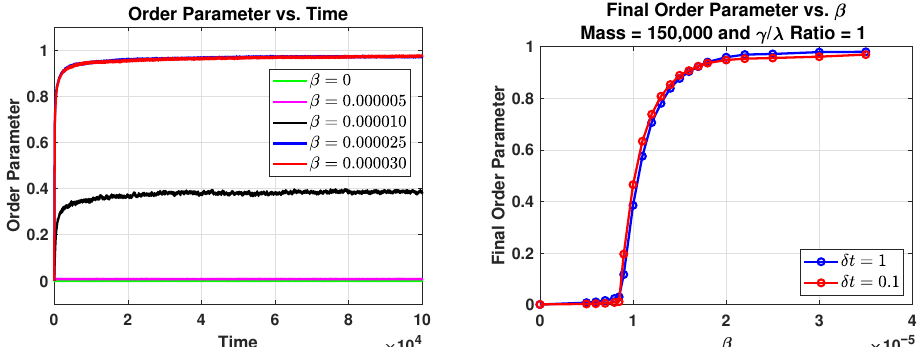
Figure 3. How changing the β parameter affects the system. Here we have N 1 = N 2 = N 3 = 50,000, with λ = γ = 0.5 and the lattice size is 100 × 100. ( Left ) It is seen that for a small β value, the system remains well-mixed and the order parameter is almost zero over all time steps. For larger β values, we see that the order parameter increases quickly as the system segregates and levels off to around one. ( Right ) After 100,000 time steps, we take the order parameter value for different β values. We clearly see that as the β value increases, there is a critical β value at which a phase transition